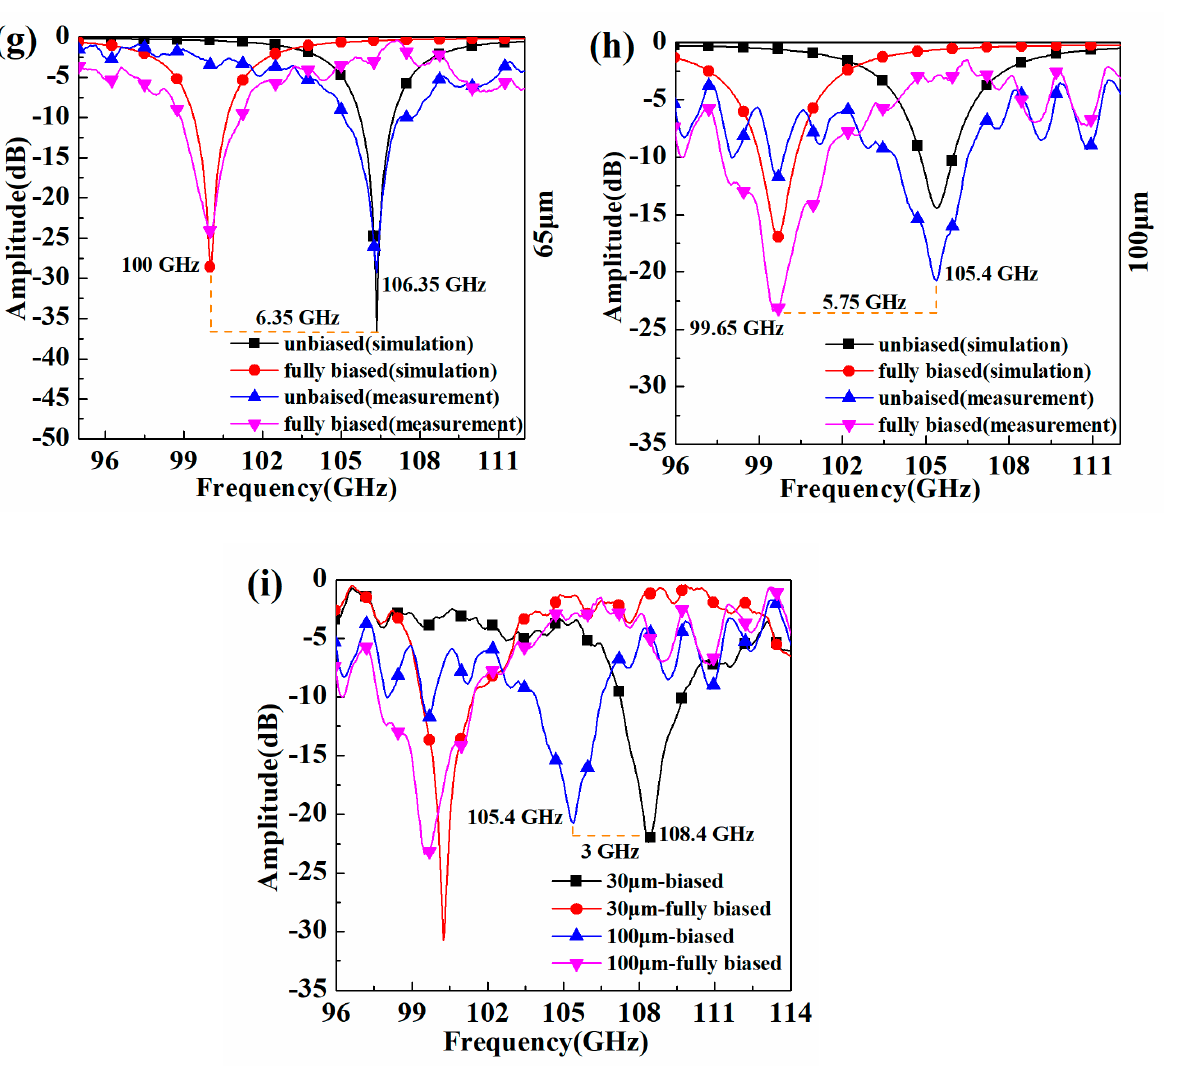
Figure 3. with different thicknesses: ( a ) hlc = 30 µm, ( b ) hlc = 35 µm, ( c ) hlc = 40 µm, ( d ) hlc = 45 µm, Figure 3. With different thicknesses: ( a ) hlc = 30 µ m, ( b ) hlc = 35 µ m, ( c ) hlc = 40 µ m, ( d ) hlc = 45 µ m, ( e ) hlc = 50 µm, ( f ) hlc = 60 µm, ( g ) hlc = 65 µm, and ( h ) hlc = 100 µm. ( i ) Measured reflection spectra ( e ) hlc = 50 µ m, ( f ) hlc = 60 µ m, ( g ) hlc = 65 µ m, and ( h ) hlc = 100 µ m. ( i ) Measured reflection spectra at 30 and 100 µm. at 30 and 100 µ